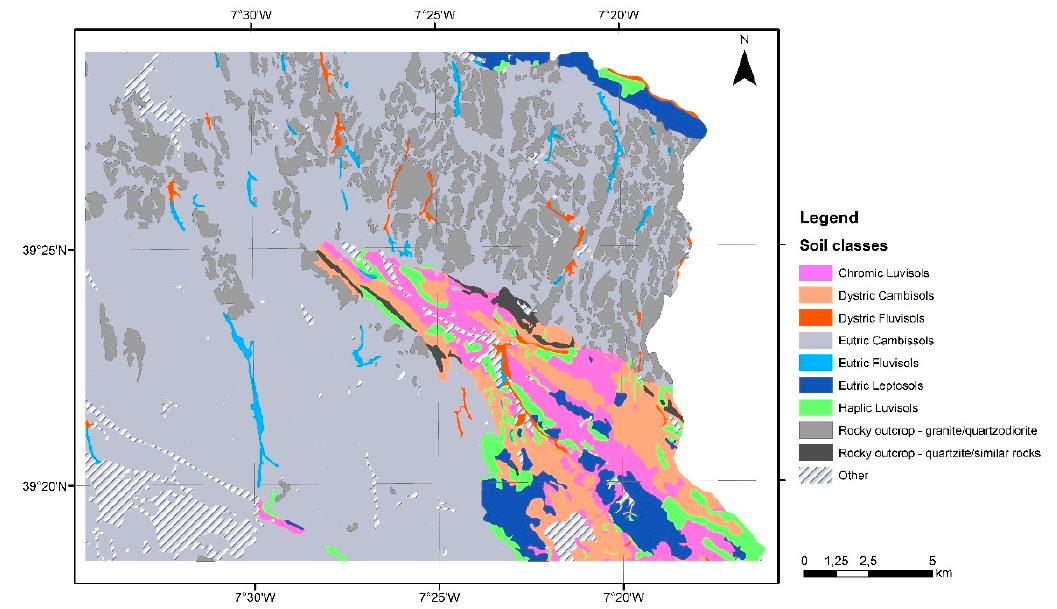
Figure 4. Main soil type classes in the study area.